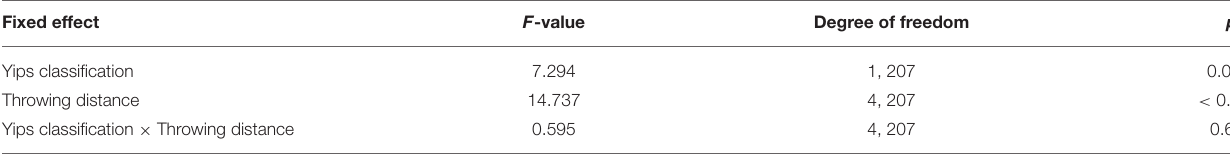
TABLE 3 | Statistical results of GLMM for the effect of yips classification and throwing distance on the frequency of the throwing errors. Fixed